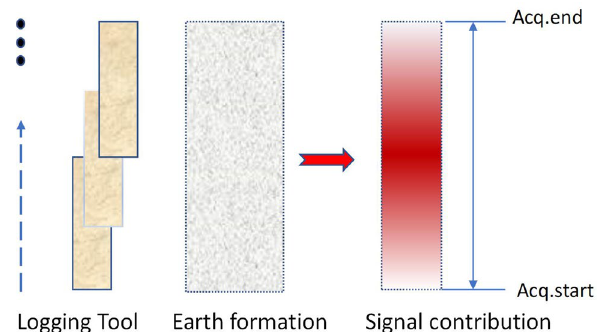
Figure 11. Contribution of the detection area to the acquired signal in one acquisition cycle during the upward movement of the NMR logging